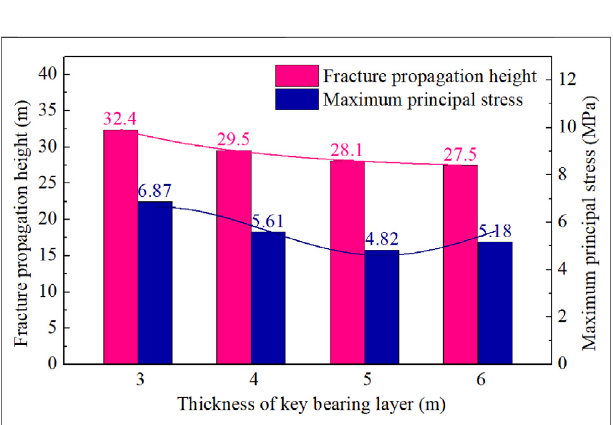
FIGURE 11 | Curves of the height of fracturing and the maximum principal stress versus fi lling thicknesses.